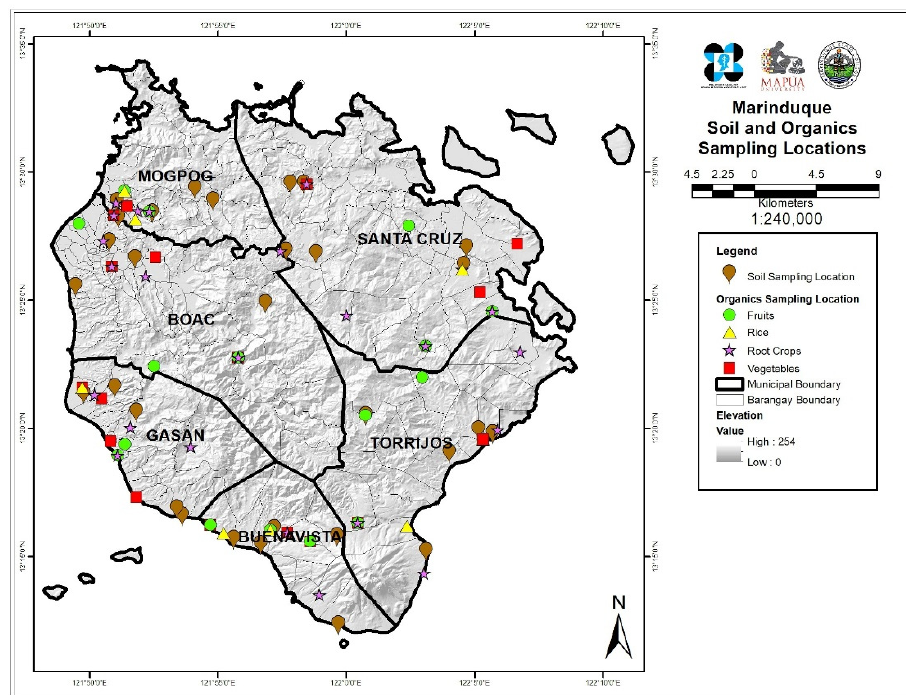
Figure 1. Map of the study area and locations of sampling